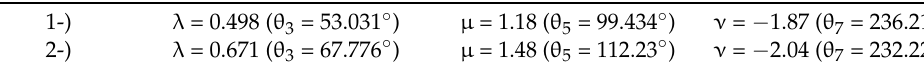
Table 9. Possible ( λ , µ , ν )